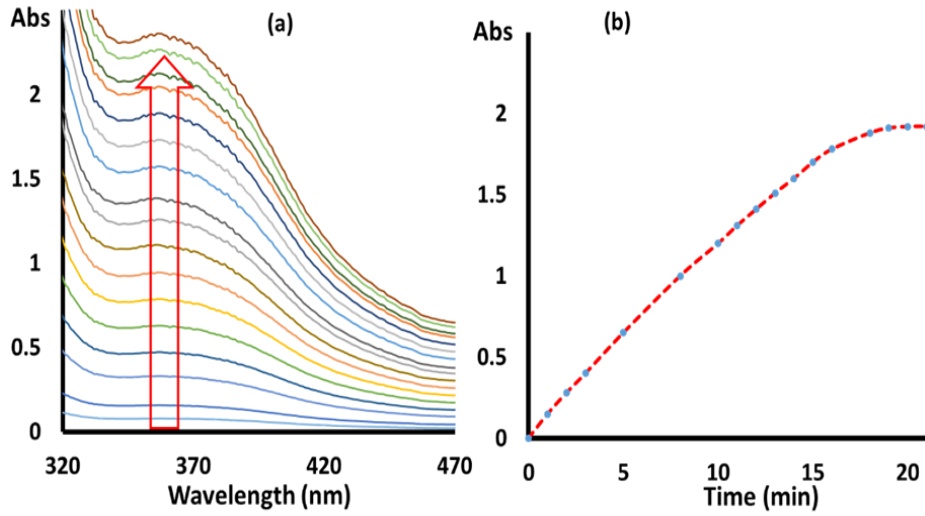
Figure 11. ( a ) UV-Vis spectra of formation of 1,2-benzoquinone from o-catechol using complex 3 catalytic matrix, and ( b ) relation graph between absorbance at λ = 358 nm and time.